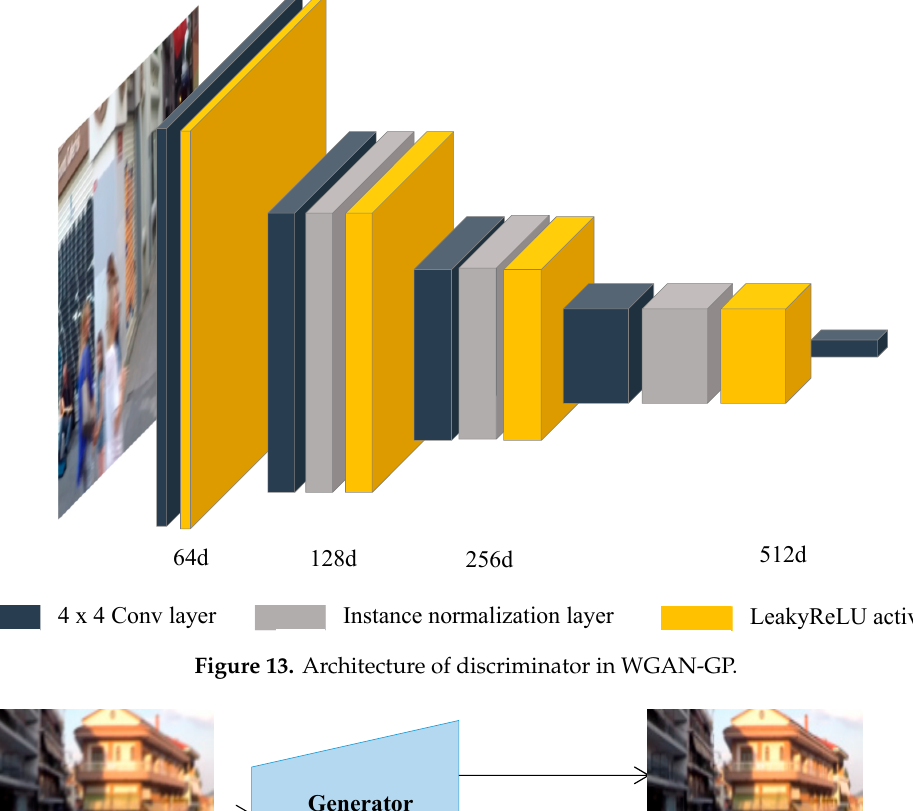
Figure 12. Architecture of generator in WGAN-GP.